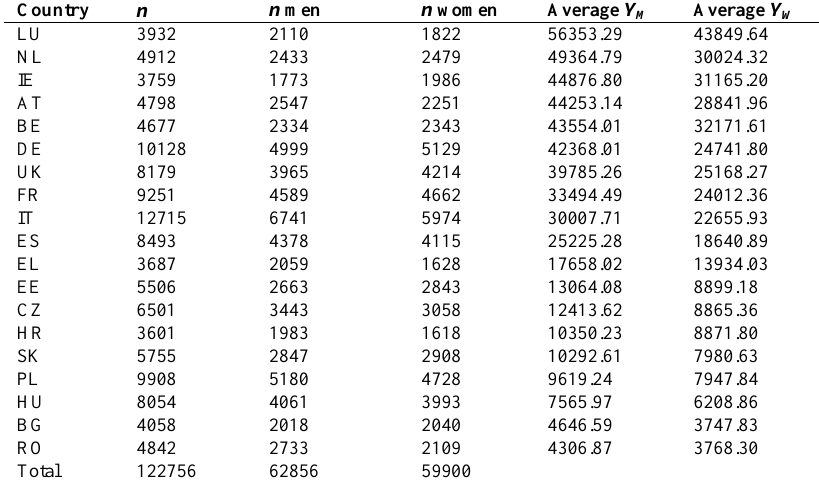
Table 1. Sample size and average annual income (in Euro) in selected countries Country